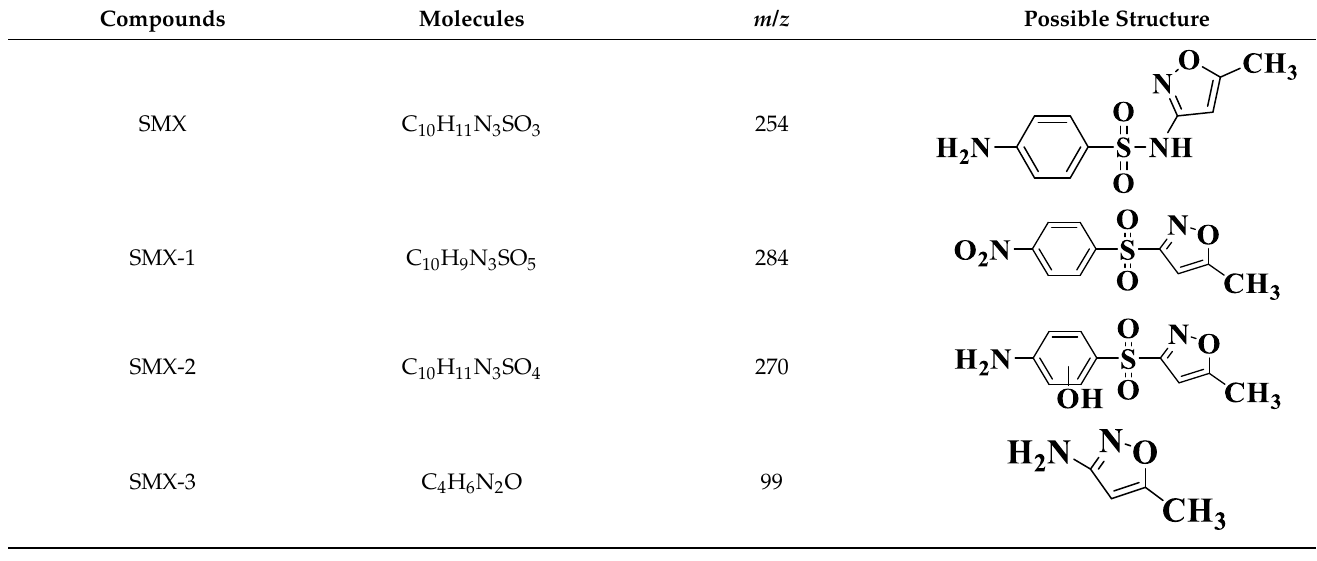
Table 2. The relative molecular weights and possible structural formulae of SMX photo-degradation intermediates.